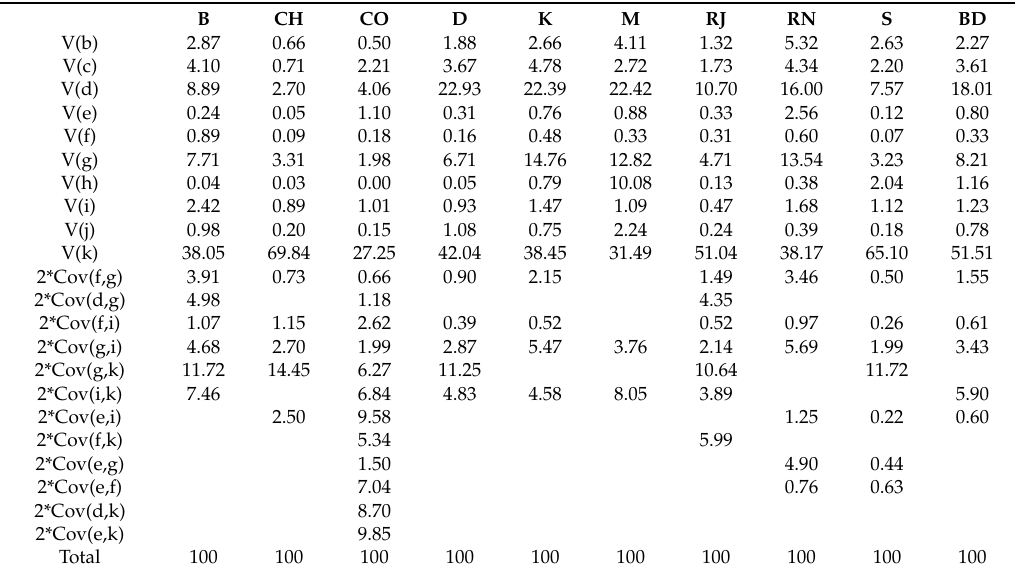
Table 11. Decomposed variance share (%) of costs for boro HYV rice production, by region. B CH